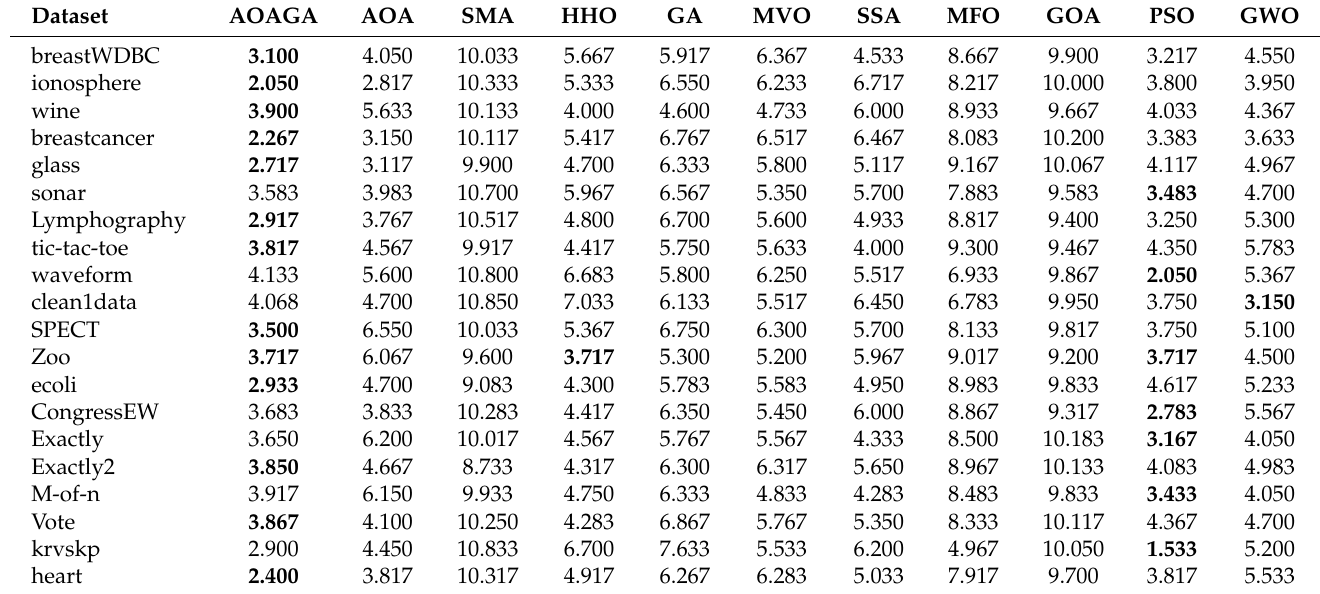
Table 9. Results of the Friedman statistical